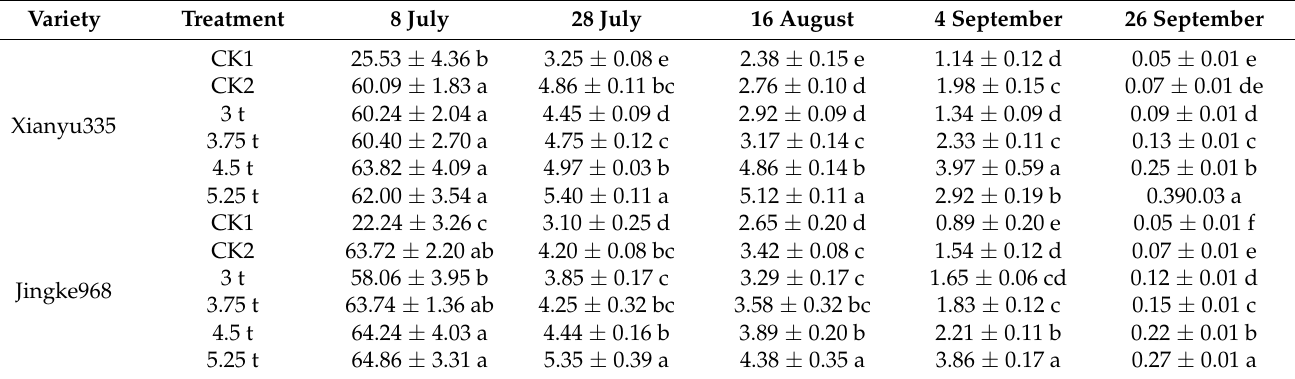
Table 3. Effect of carbon-based fertilizer on soil ammonium nitrogen content